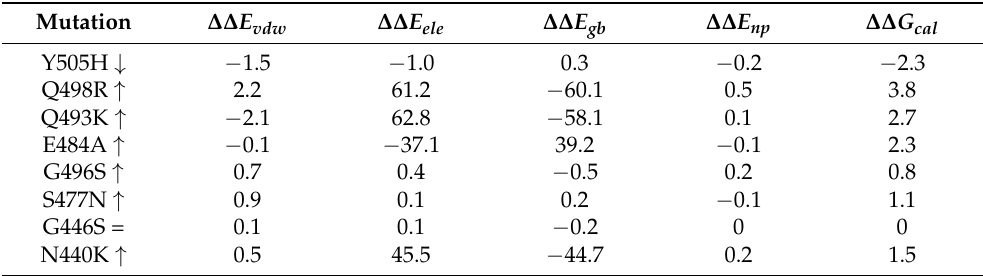
Table 4. Calculated binding energy differences between specific single point mutants (Y505H, Q498R, Q493K, E484A, G496S, S477N, G446S and N440K) and the wild-type SARS-CoV-2 S protein in binding to ACE2 by the ASGB method. The energy values are in